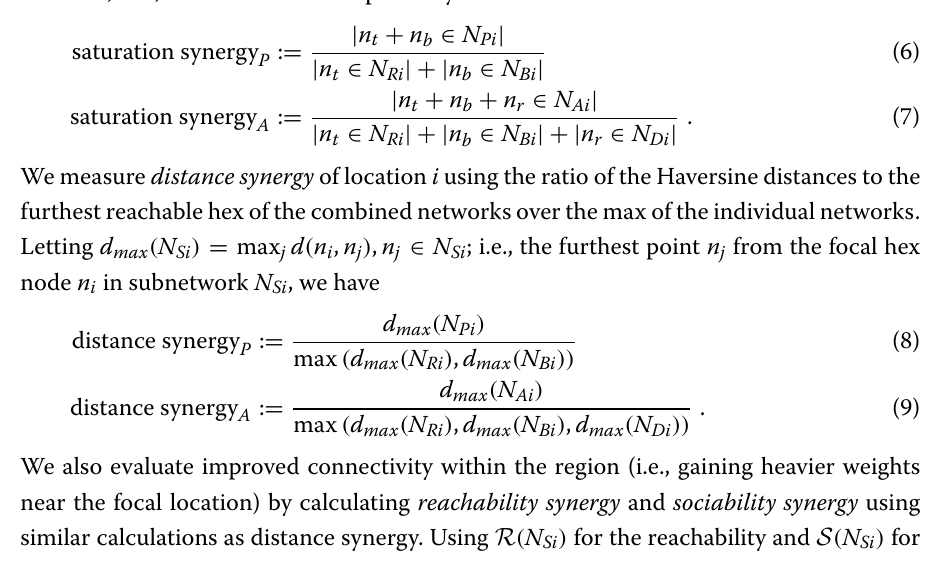
dominated by one of the transportation modes such that adding another does not expand the reachable